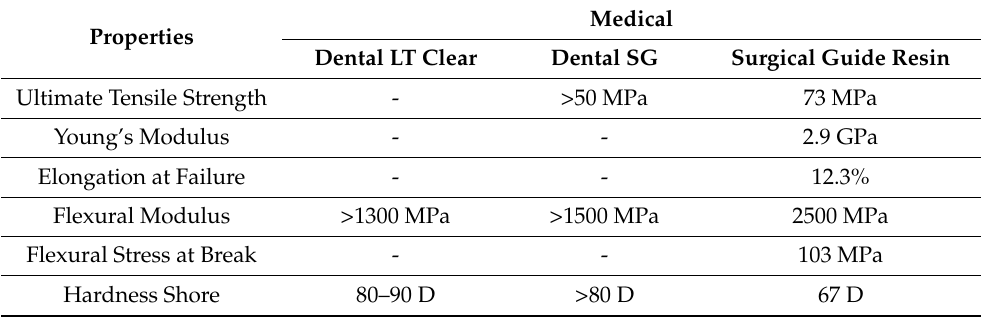
Table 6. Mechanical properties of dental resins